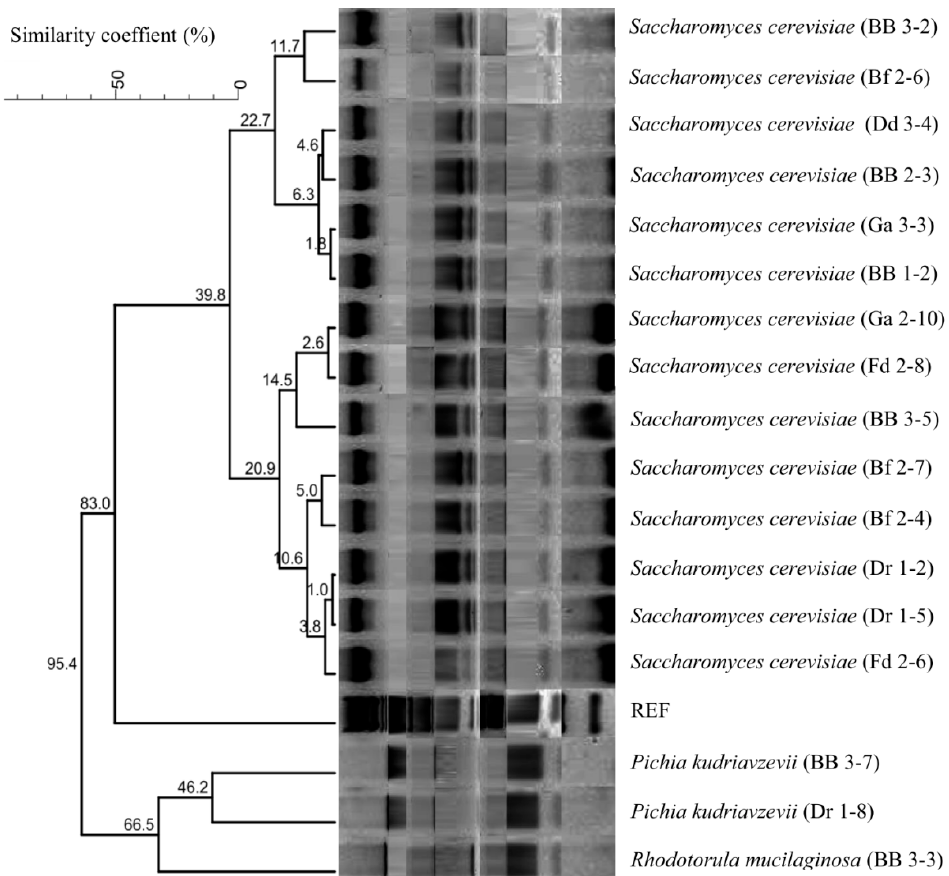
The dendrogram obtained by the comparison and clustering of RFLP patterns of yeast strains with the restriction enzymes Hinf I, Hha I, and Hae III and the amplicon profiles revealed the existence of the family relationships between the strains examined in this study (Figure 1).